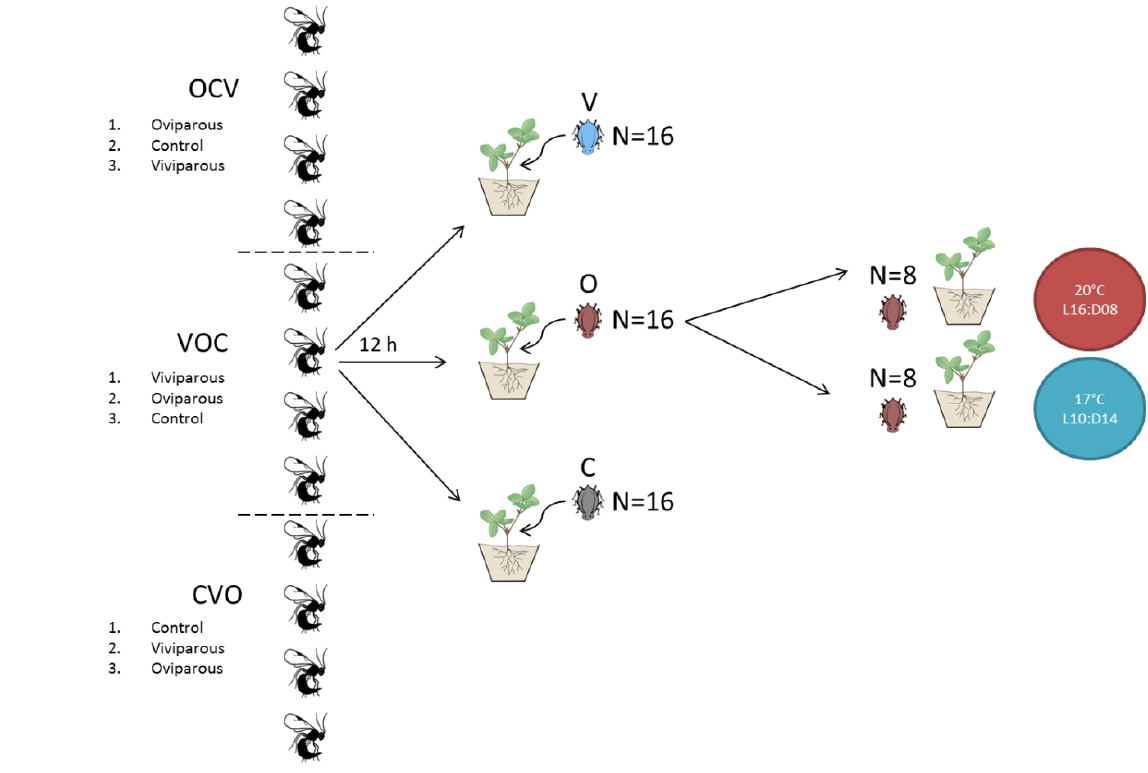
Figure 1: Experimental design for diapause induction in the parasitoid Aphidius ervi . Twelve parasitoid females were individually allowed to parasitize 16 Acyrthosiphon pisum from each of the three host morphs for 12 h: oviparous (O), viviparous (V) and viviparous control (C). First contact